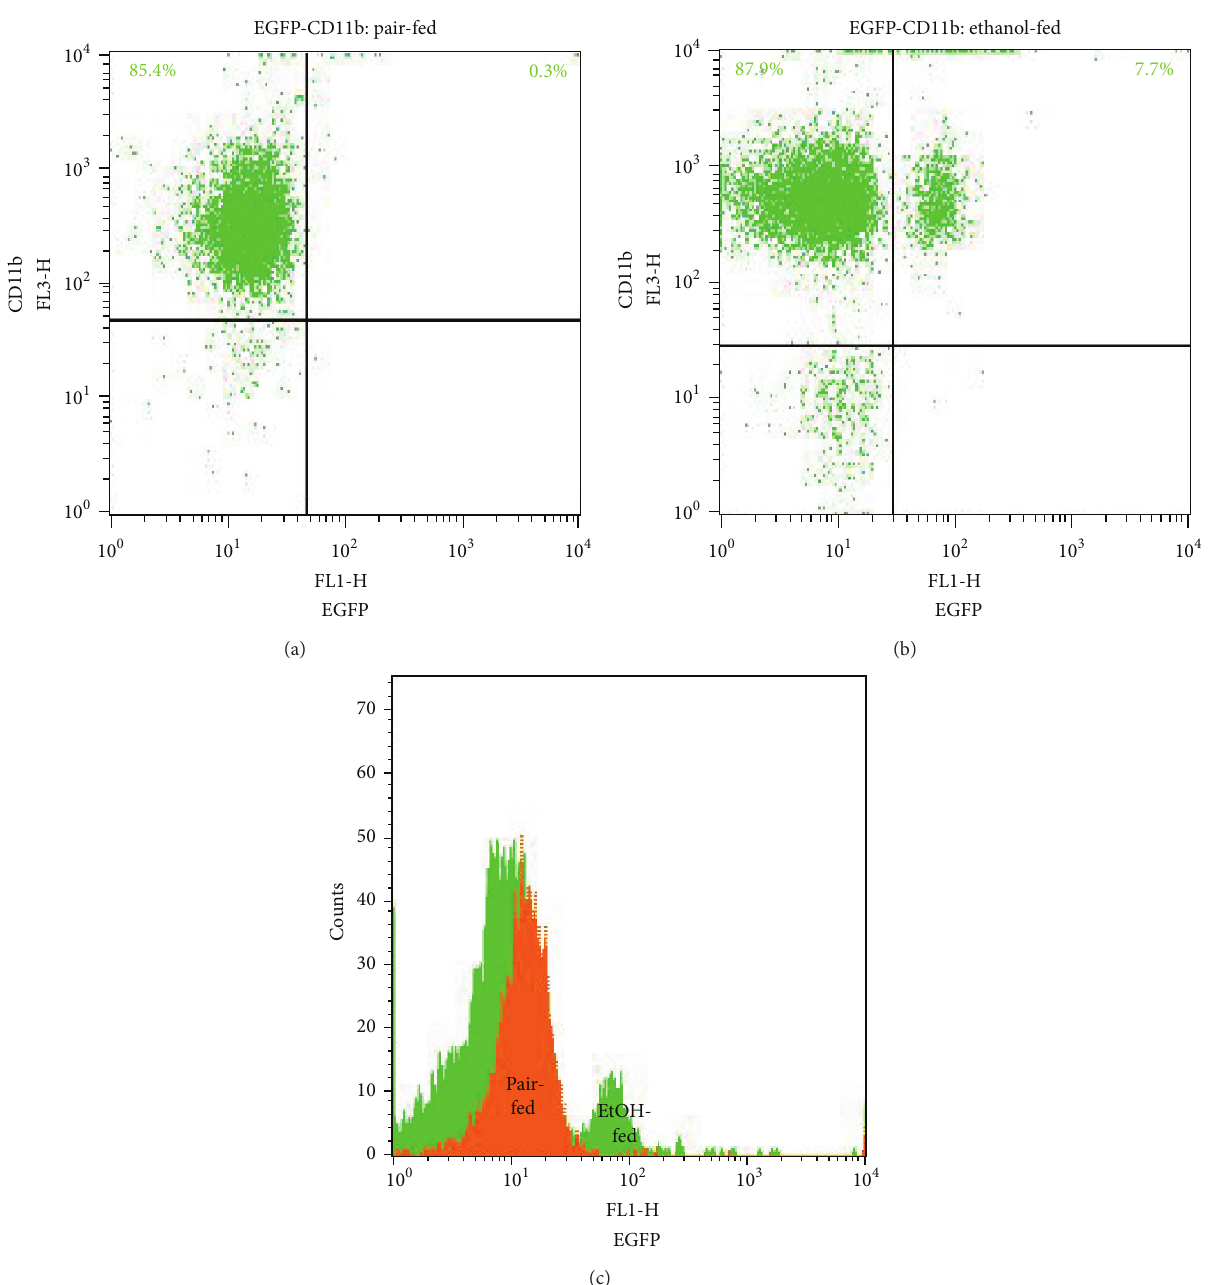
Figure 3: Surface expression of CD11b and transcriptional induction of the cis -NF-kB EGFP transgene after chronic ethanol exposure. Representative FACS diagrams are shown. EGFP expressing versus CD11b + PMNL, gated by their FSC/SSC properties as shown in Figure 1, were identified in a FL-1-FL-3 scattergram. The percentage of the indicated populations was determined through quadrant analysis of (a) pair- and (b) ethanol-fed mice. In (c), an overlay of FACS histograms, representative of five independent experiments, demonstrates elevated EGFP expression in PMNLs from ethanol pretreated mice. The orange-filled histogram depicts pair-fed controls and the green-filled graph ethanol-fed